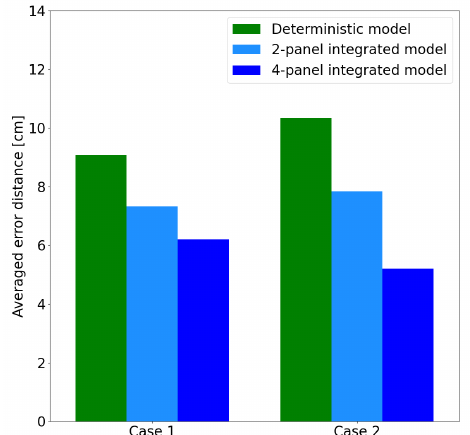
Figure 13: Averaged error distance of the predicted cage deformation from the deterministic models and the integrated